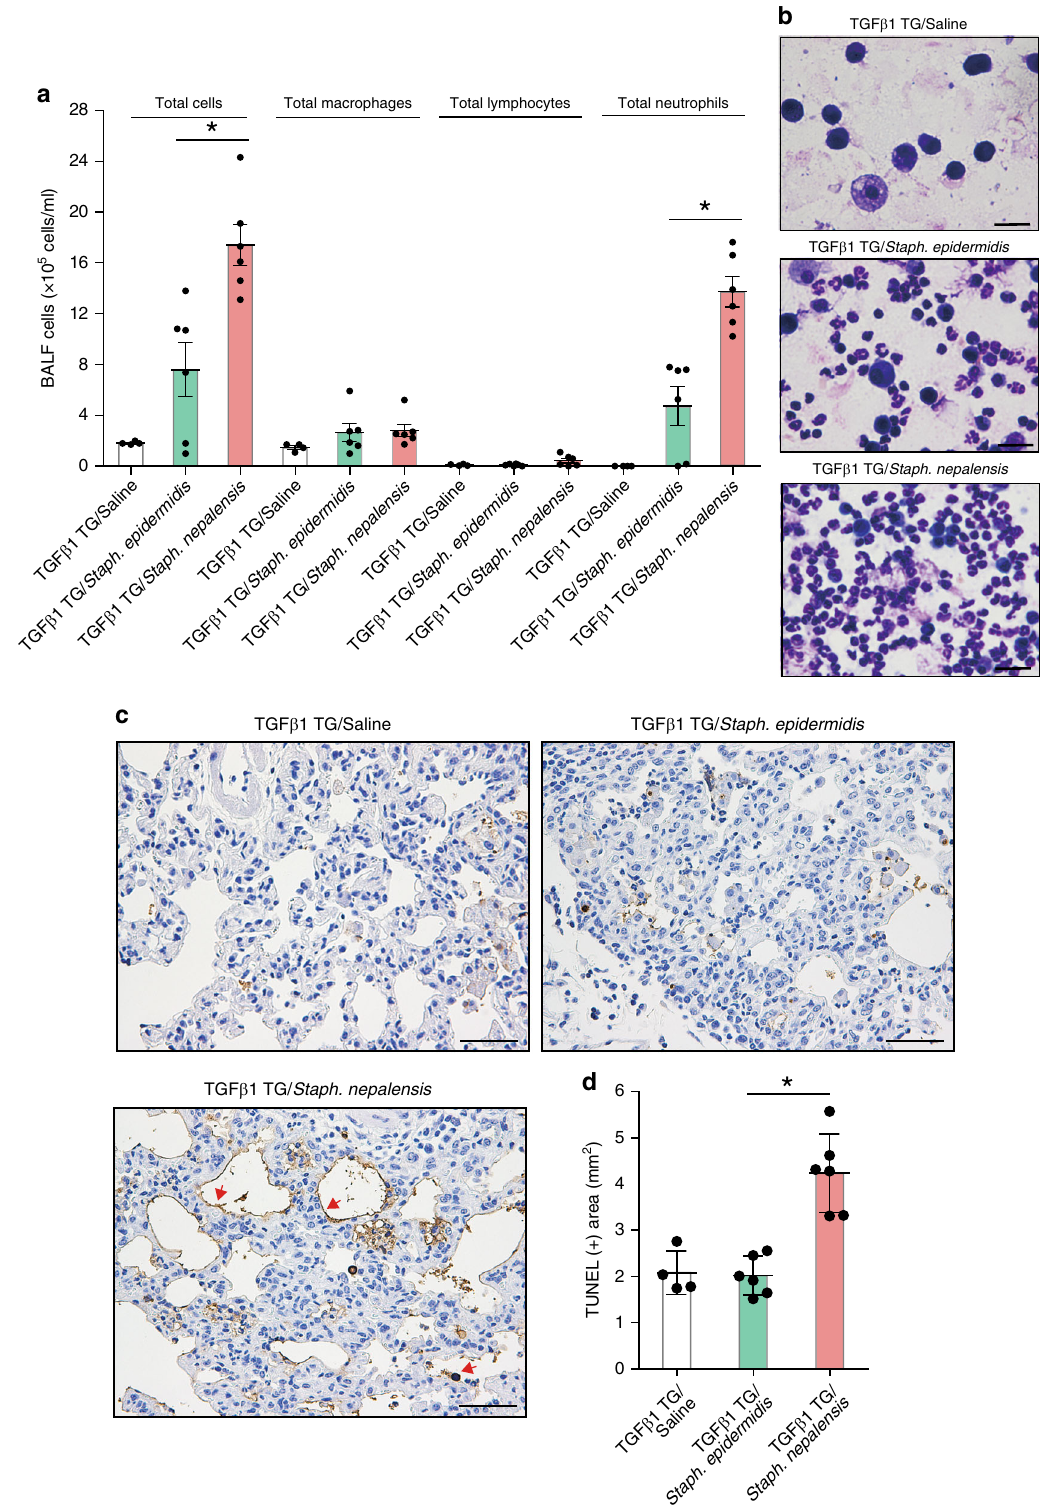
Horizontal gene transfer of the corisin-encoding gene . Sequence alignment and comparative genome analysis revealed that a pathogenic strain of Streptococcus , i.e., Streptococcus pneumoniae strain N, implicated in respiratory tract disease, contains a transglycosylase (COE35810) with a peptide sequence almost identical (a single amino acid change) to corisin. A further